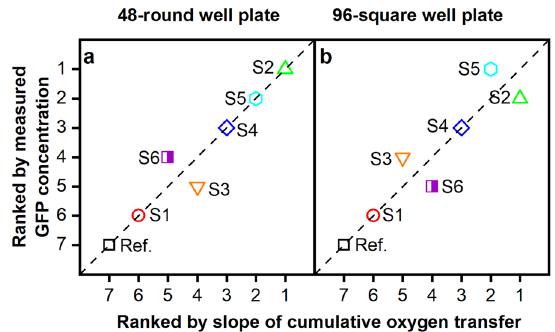
Figure 5. Parity plot of the ranking of a clone library with GFP secreting P. pastoris Mut S strains. The seven different strains were ranked by the GFP concentration measured at the end of the cultivation (y-axis). The highest GFP fluorescence results in rank 1 (best) and gradually decreases according to the GFP value obtained. On the x-axis, the slope of the cumulative oxygen transfer was used as ranking criterion (see Supplementary Table 2). Here, the lowest slope is ranked as 1 (best). If the data points lie on the angular bisector, the ranking result was identical for both methods. The results for a cultivation in 48-round well plates (Fig. 3) is shown in ( a ) and for the cultivation in 96-square well plates (Supplementary Figs. 2 and 3), respectively, in ( b ).